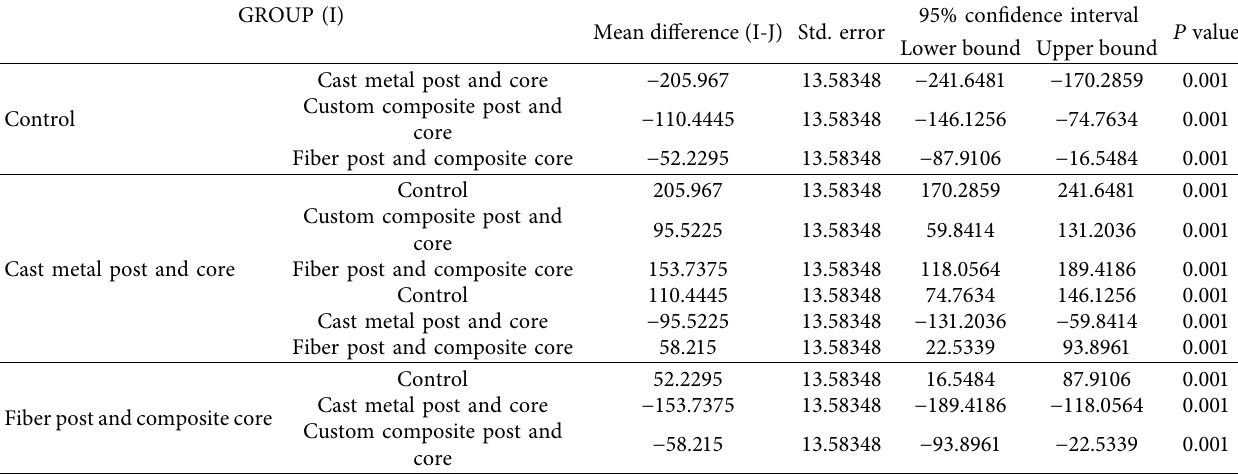
Table 3: Inter group comparison between Control and Experimental groups using Tukey HSD post hoc test.